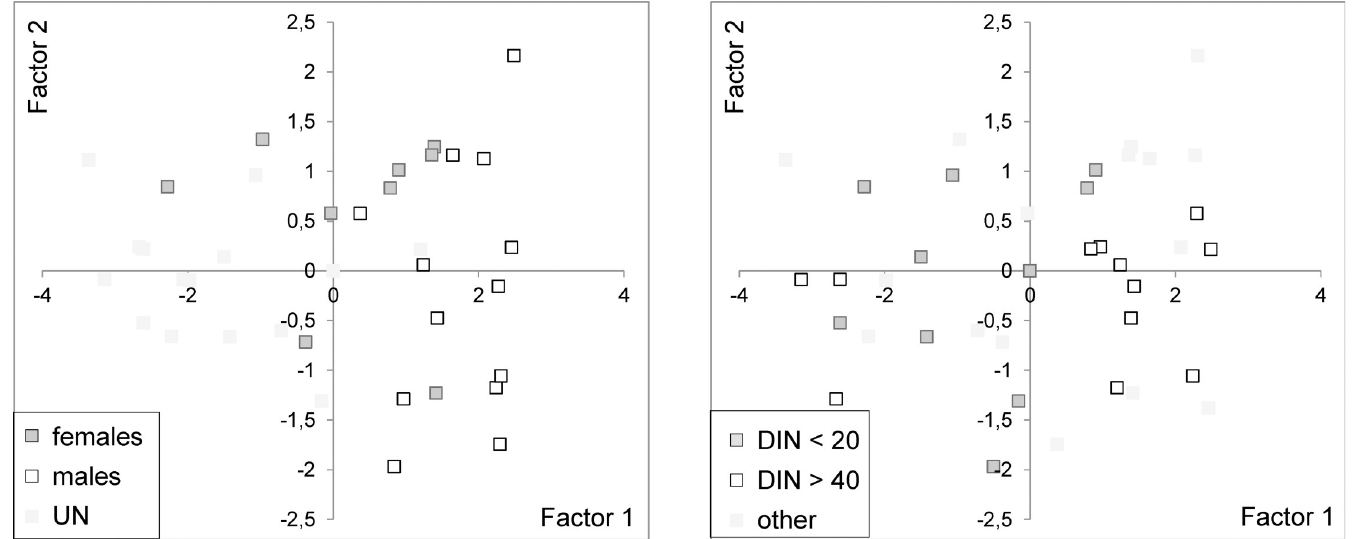
Fig 4. PCA on the severity of skin mark types. Plots of the component scores on Factor 1 and Factor 2 according to the percentages of explained variance showing different severity for marks between a) males and females and b) dolphins with DIN more than 40% or less than 20%. Each dolphin was identified by the photo-id code (PHD), sex (m = male, f = female, u = unknown), and age class (a = adult, j = juvenile, c = calf, u = unknown). For each mark type, the loadings on Factor 1 and Factor 2 were also reported.